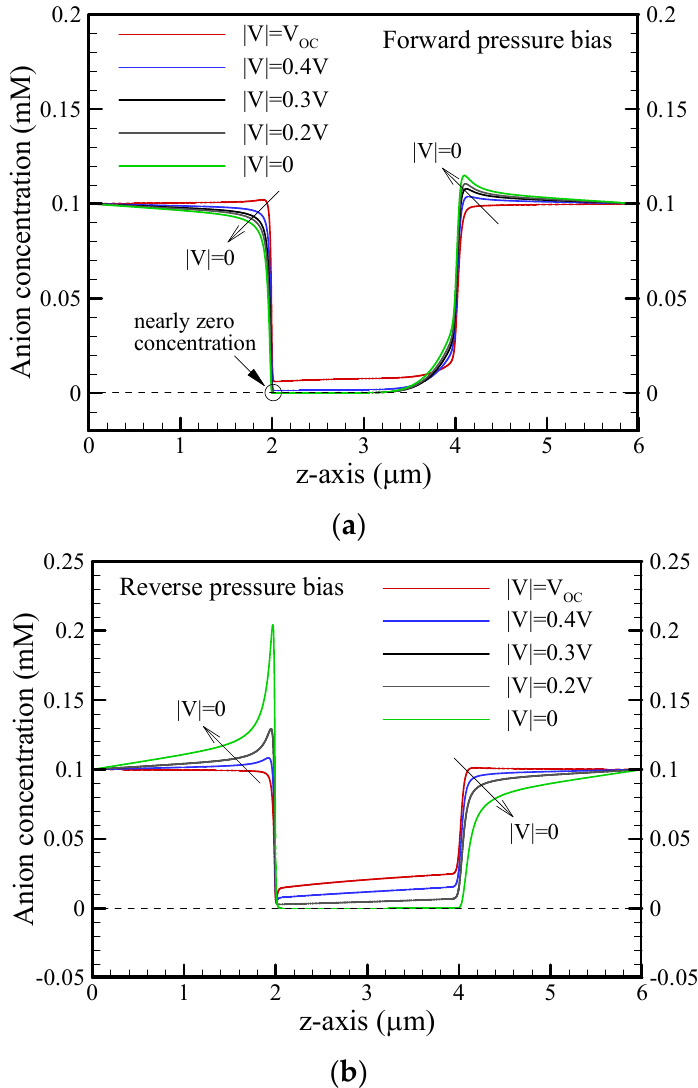
Figure 11. Plots of the anion (Cl − ) concentration along the centerline of the reservoir and conical nanopore for different voltages of |V| at a salt concentration of c 0 = 0.1 mM and pressure bias of p ext = 500 kPa. ( a ) Forward pressure bias; ( b ) Reverse pressure bias. Note that θ = 1.2 ◦ , σ s = −5 mC/m 2 , and b = 20 nm.